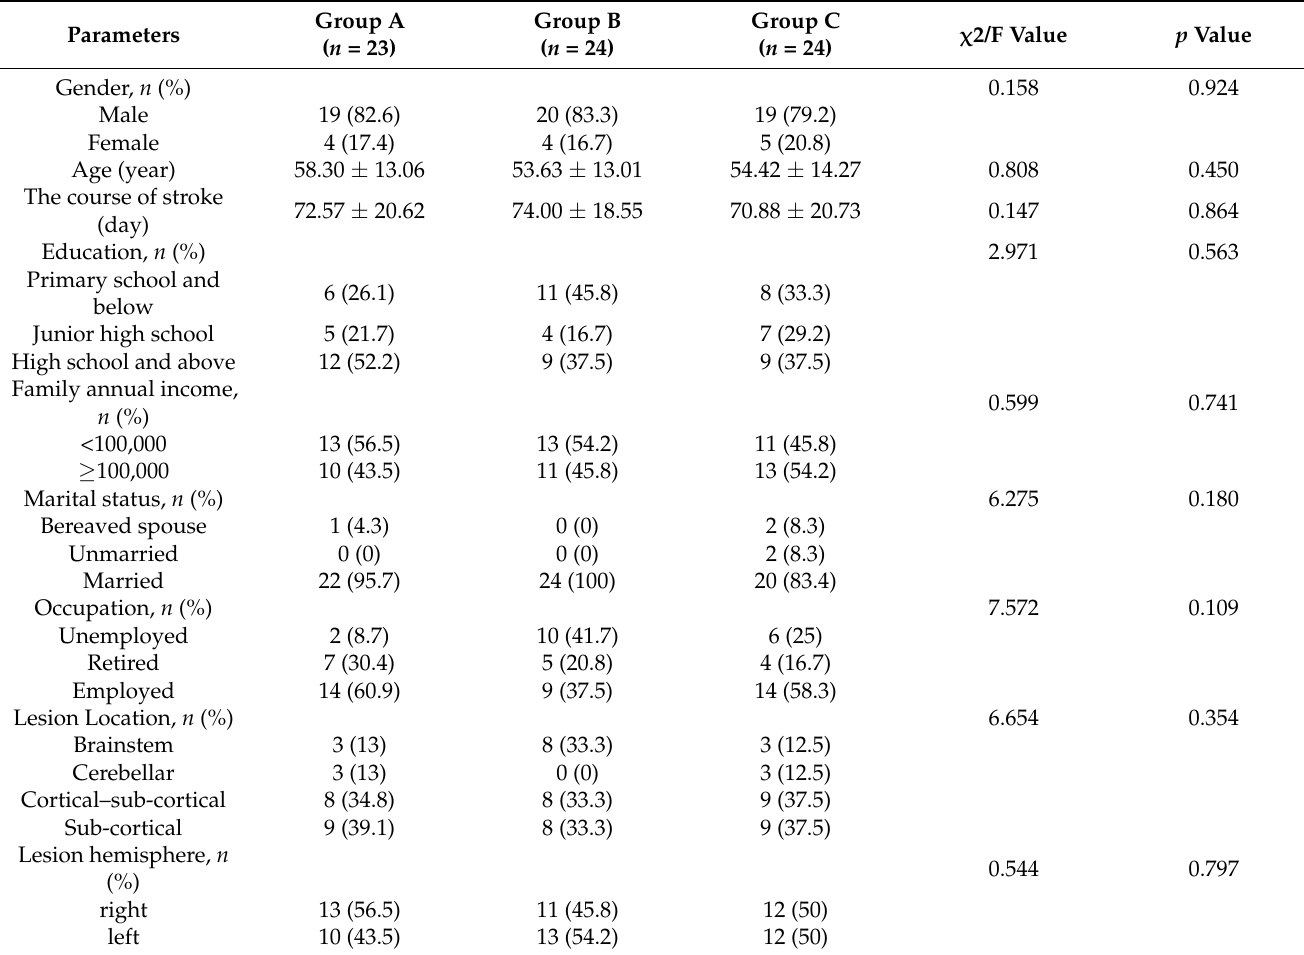
Table 1. General characteristics of subjects ( n =